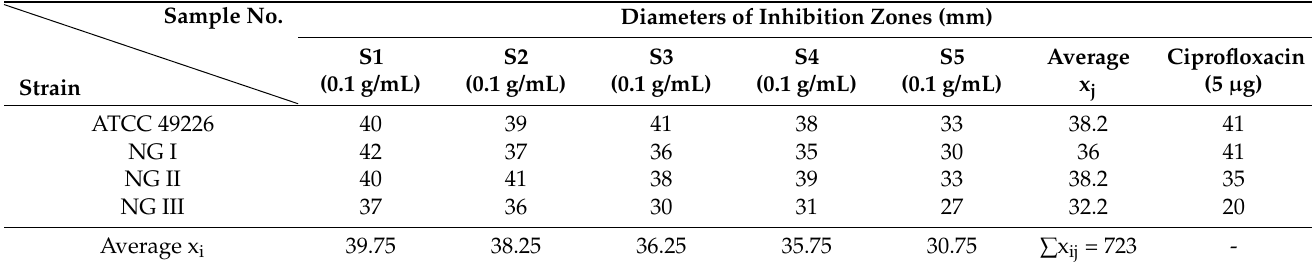
Table 2. Diameters of the inhibition zones of the microbial strains for the aqueous extracts of propolis and ciprofloxacin. Sample Strain